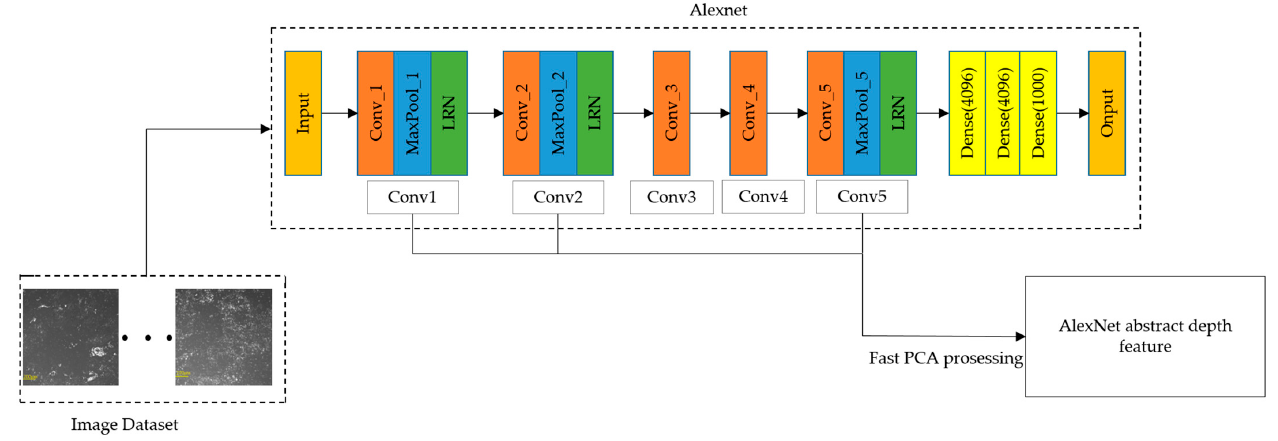
Figure 6. Flowchart of extracting the Alexnet abstract-depth feature.